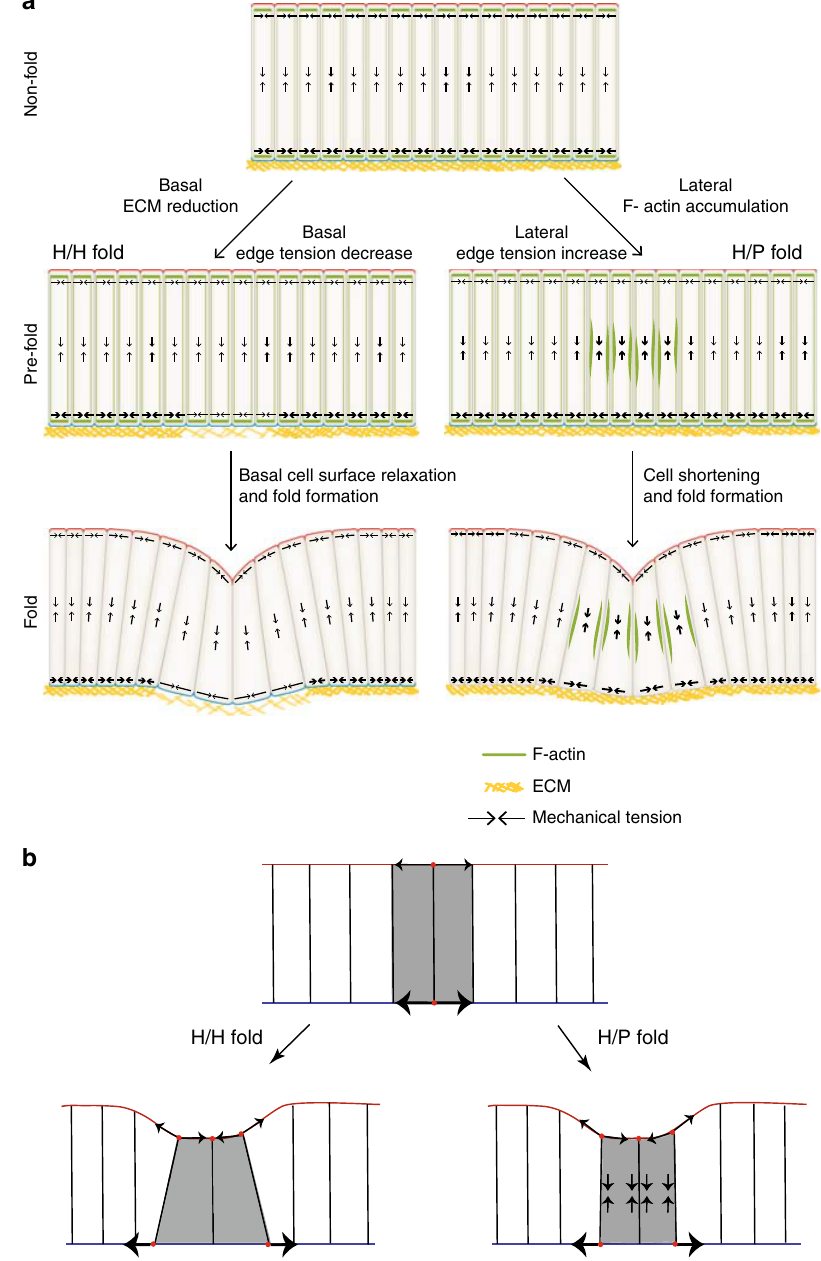
Fig. 8 Two distinct mechanisms drive H/H and H/P fold formation. a Top: scheme of a cross-sectional view of an unfolded epithelium. Note that basal tension is greater than apical tension. Basal tension depends on ECM. The H/H fold and the H/P fold form through two distinct mechanisms. Left: prior to H/H fold formation (pre-fold) a local reduction of ECM leads to a relaxation of basal tension. The decrease of basal tension results in the widening of the basal side of the pre-fold cells; cells adopt a wedge-like shape that drives fold formation. Right: prior and during H/P fold formation, fl uctuations of F-actin accumulation at lateral cell interfaces leads to increased lateral tension driving pulsatile cell height contractions. Since apical tension is lower than basal tension, cell shortening leads to apical invagination and fold formation. b Simpli fi ed picture of mechanism of fold formation. Top: basal tension is greater than apical tension in the unfolded epithelium. Left: in the H/H fold, high basal tension of the neighboring cells stretches the basal surface of the fold cells, in which basal tension is reduced. Cells widen basally and reduce cell height to maintain their volume. Right: in the H/P fold, high lateral tension leads to a reduction in cell height. Since basal tension is high, the shortened cells deform the apical surface inwards, while the basal surface resists Apical and basal laser ablation . For laser ablation experiments, cell edges were imaginal discs were recorded with a time delay of 0.25 s. The vertex displacement after laser ablation was analyzed with Fiji 46 . The two vertices of the ablated cell visualized by indy-GFP. 30A-Gal4 > UAS-CD8-mCherry and Doc-Gal4 > UAS-CD8 mCherry were used to label the H/H fold and H/P fold, respectively. Wing imaginal edges were manually tracked in the recorded images and the vertex distance discs were mounted in culture medium with their apical side facing the objective increase over time measured. The average recoil velocity v 0 was obtained by for cutting apical cell edges. For cutting basal cell edges, the basal side was facing measuring the vertex distance increase between the time point before ablation and the objective. An inverted microscope with a ×63/1.2 numerical aperture water- the fi rst image acquired 0.25s after ablation, and dividing by 0.25 s. The average immersion objective equipped with a pulsed, third harmonic solid-state ultraviolet- recoil velocity is taken as a measure of relative mechanical tension on the cell edge laser (355nm, 400 ps, 20mJ/pulse) was used for ablating single-cell edges. Wing before ablation 27 (see Supplementary Methods).